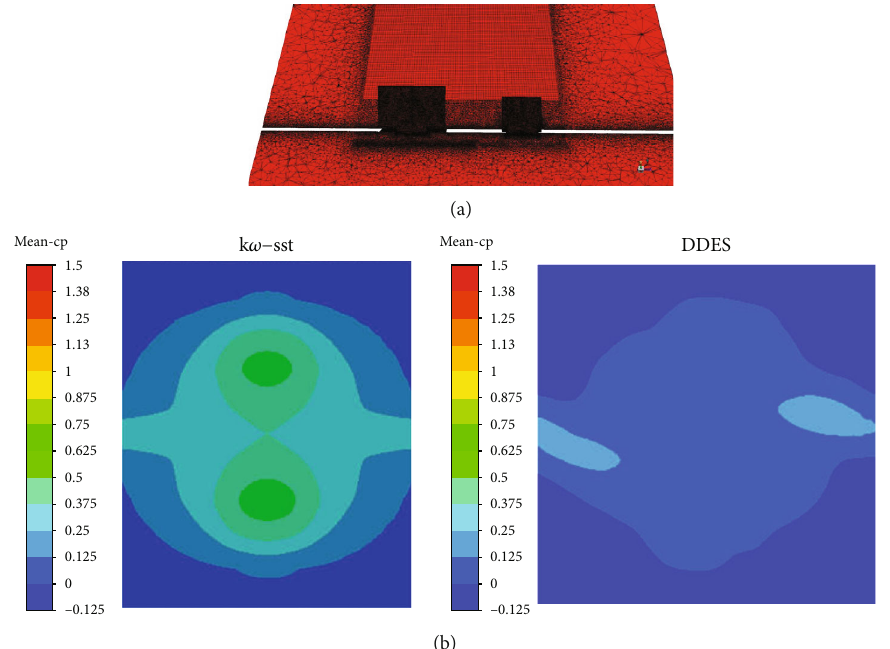
Figure 3: (a) Final computational grid for arrangement of 90new3-30 with DES model requirements illustrated on horizontal plane. (b) Comparison of DDES and k ω - sst -based numerical simulations to capture the 90 ° standard airfoil wake axis switching illustrated as time- averaged cp contours at station 7.